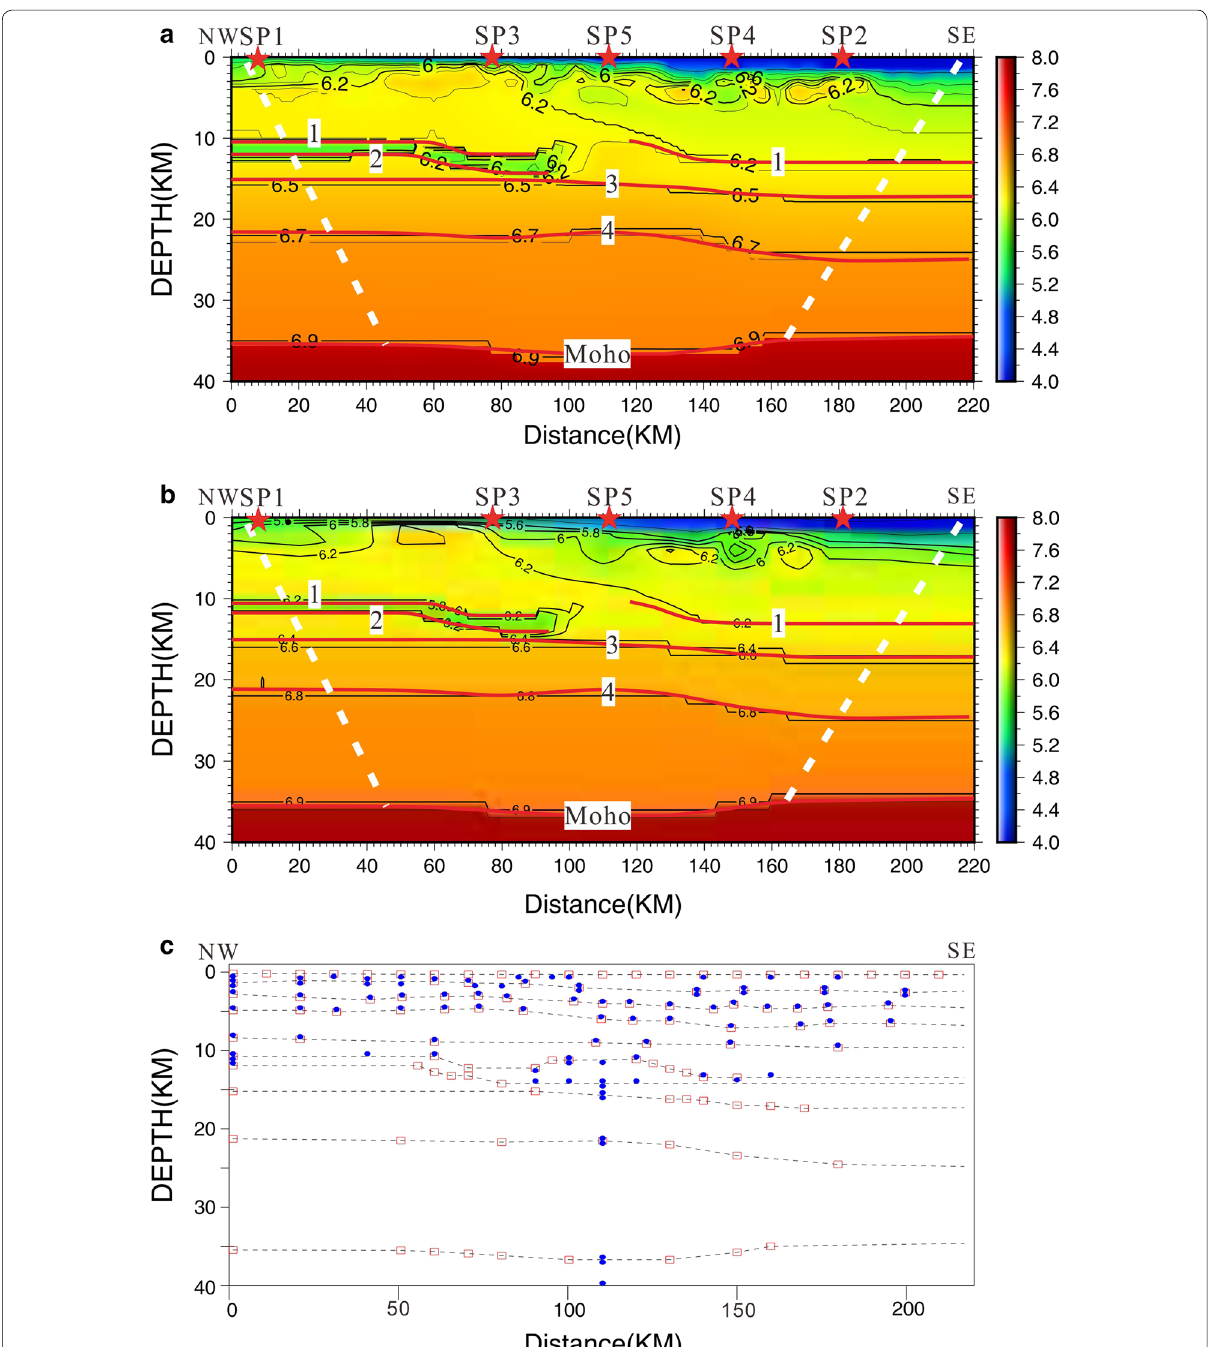
Fig. 7 P-wave velocity structure along the Line 1 seismic profile and the model structure of Rayinvr program. The red line indicates the reflection boundaries used in the inversion. The red stars indicate the shotpoints (SP). There is no seismic coverage beyond the white dashed lines. The wide-angle reflections P1P, P2P, P3P, P4P, and PmP are generated from boundaries 1, 2, 3, 4, and Moho, respectively. a The velocity structure obtained by the regularized inversion algorithm of the first-arrival traveltimes and Rayinvr program. b The crustal velocity structure obtained by using Rayinvr. c The nodes we used to model the seismic velocity structure of Fig. 7b. The red boxes indicate the nodes used to model the boundaries in the crust, and the blue dots used to indicate the seismic velocity nodes above and beneath the boundaries. The nodes between 0 and 7 km are used to resample the upper crustal model obtained by Pg inversion (0–8 km of Fig. 7a), and they are fixed in the employment of Rayinvr program. The other nodes are adjusted to obtain Fig. 7b with the seismic phases (P1P, P2P, P3P, P4P, PmP and